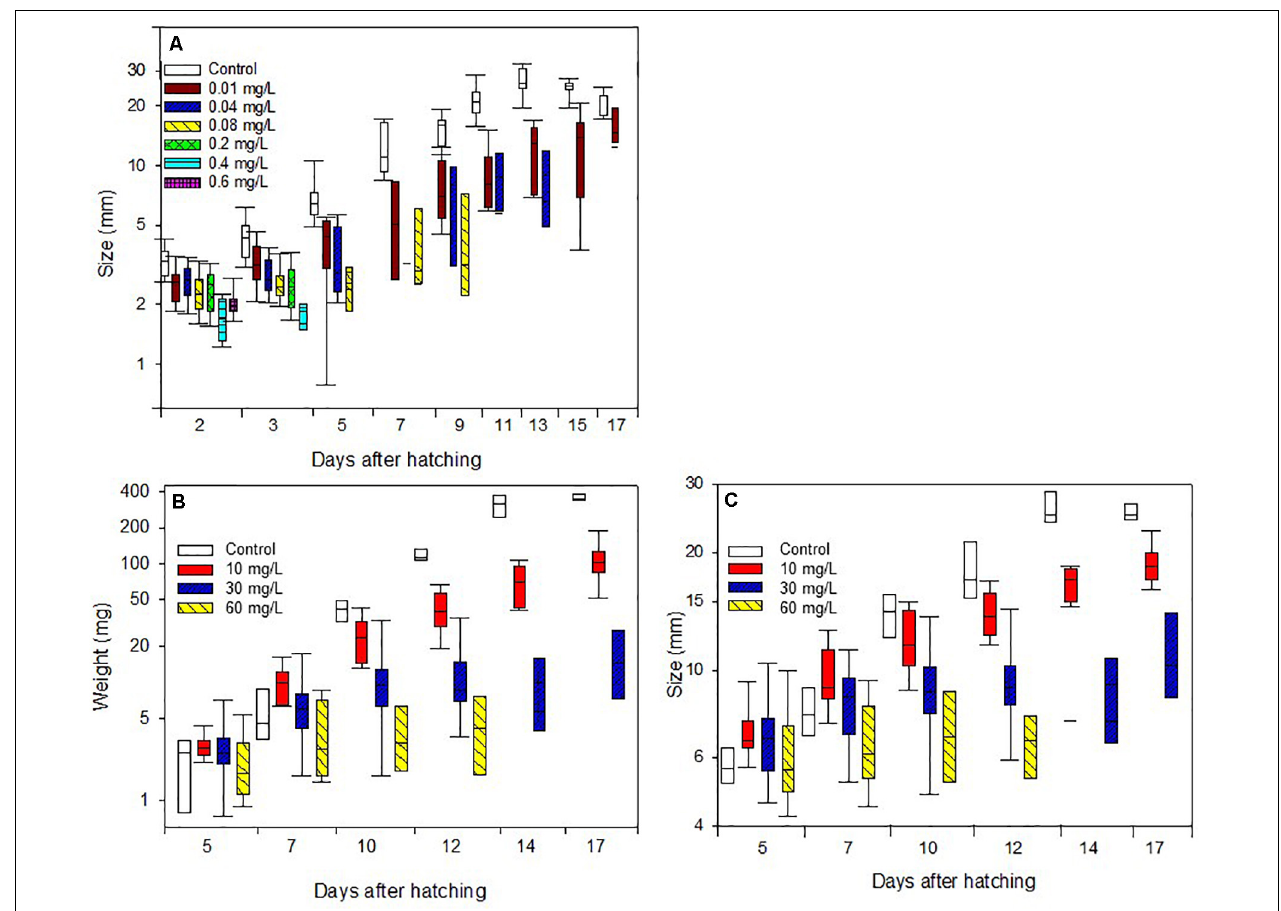
FIGURE 2 | Body length increase of caterpillars (A) treated with Spinetoram, (B) body mass increase, and (C) body length increase of caterpillars treated with